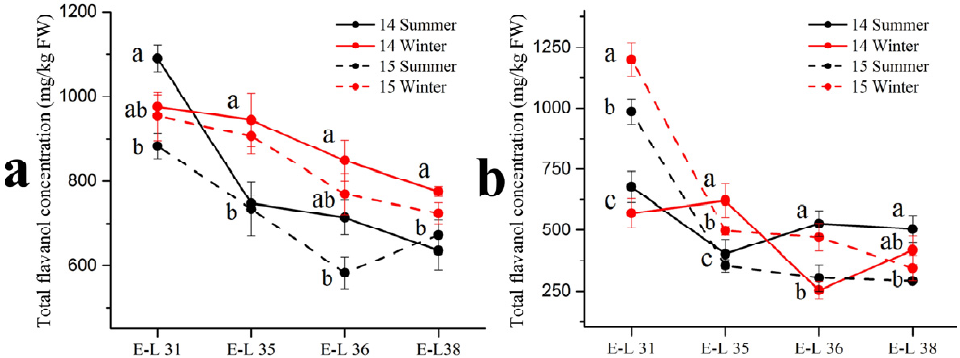
Figure 3. Total flavanol concentration in ‘Muscat Hamburg’ grapes ( a ) and ‘Victoria’ grapes ( b ) in 2014 and 2015 under the double cropping system. Different letters within the same development stage indicate significant differences among seasons (Duncan’s multiple range test at p < 0.05). To better understand how the phenolic profiles varied in ‘Muscat Hamburg’ grapes and ‘Victoria’ grapes, as well as in different seasons. The principal component analysis (PCA) was used to classify the different samples, which consisted of all the four development stages of two varieties in different seasons, as shown in Figure 4 and Supplementary Figure S1. The first two principal components explained 70.4% of the total variance. PC1 accounted for 51.8% of the total variance, which could separate samples from MH